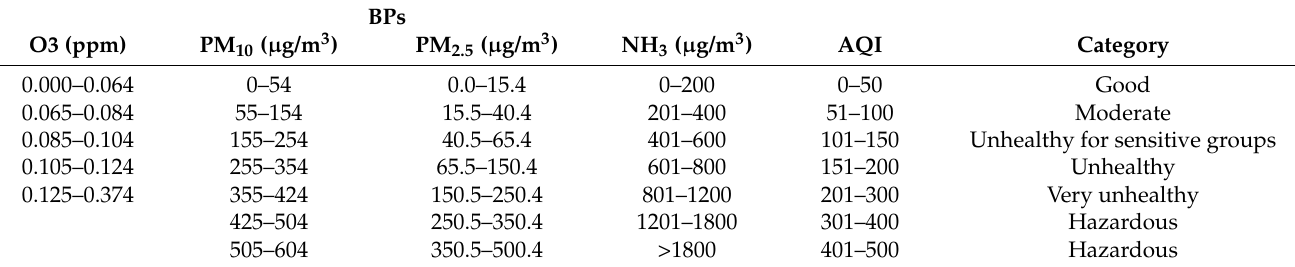
Table 1. Parameters needed for AQI calculation for an 8 hour or 24 hour exposure period (extracted and edited from the Environmental Protection Agency (EPA) guidelines [31]). BP, Break Point. BPs